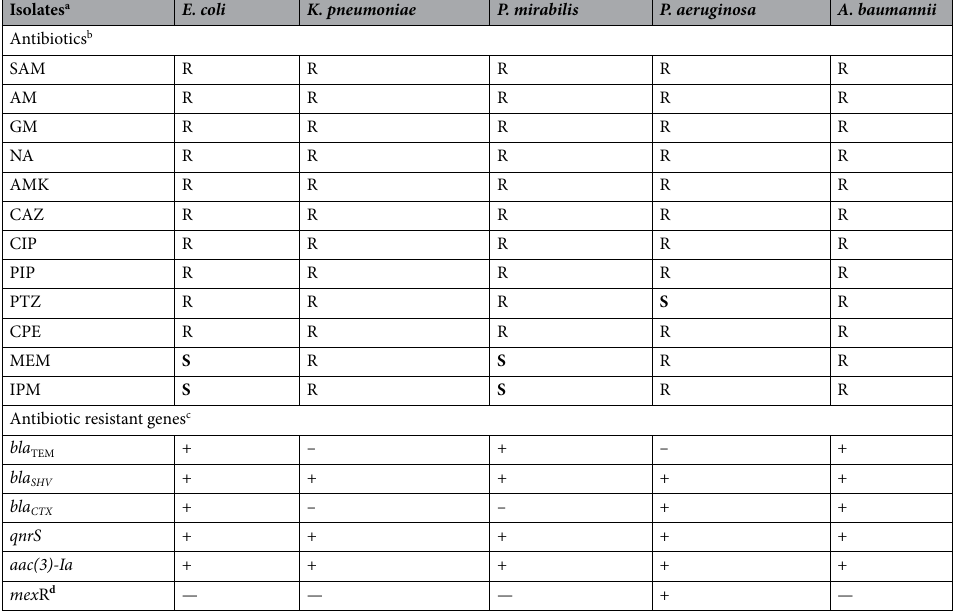
— — — + — Table 2. Antimicrobial susceptibility and antibiotic resistant genes of multidrug resistant uropathogens isolated from urine. a Escherichia coli, Klebsiella pneumoniae, Proteus mirabilis, Pseudomonas aeuroginosa, Acinetobacter baumanii. b SAM (Ampicillin-sulbactam), AM (Ampicillin), GM (Gentamicin), NA (Nalidixic